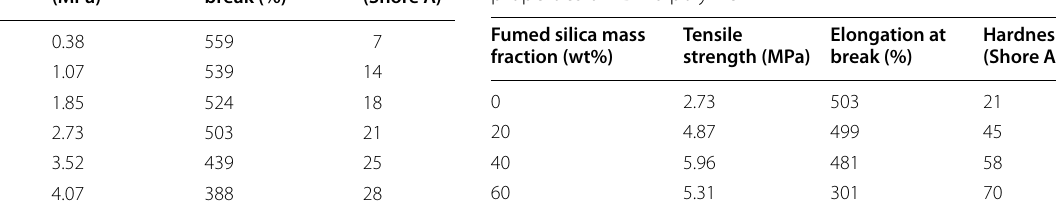
Table 7 Effect of fumed silica mass fraction on